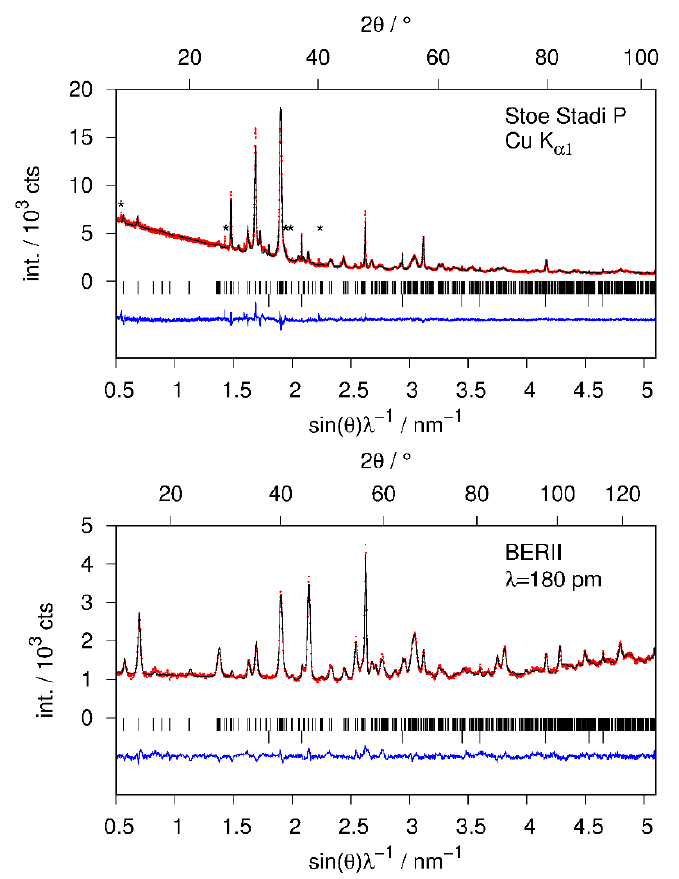
Figure 4. Rietveld of the crystal structure of CaSiD 1.1 ( Pnma ) using X-ray ( top ) and neutron diffraction data ( bottom ) simultaneously; R wp = 4.20%, R p = 3.20%, GoF = 1.90; Bragg marker are: top row CaSiD 1.1 , bottom row CaO (2 wt %); (*) marks an unidentified impurity phase already present in the pristine Zintl phase (see text); red points, observed intensity; black line, calculated intensity; blue line, difference plot.